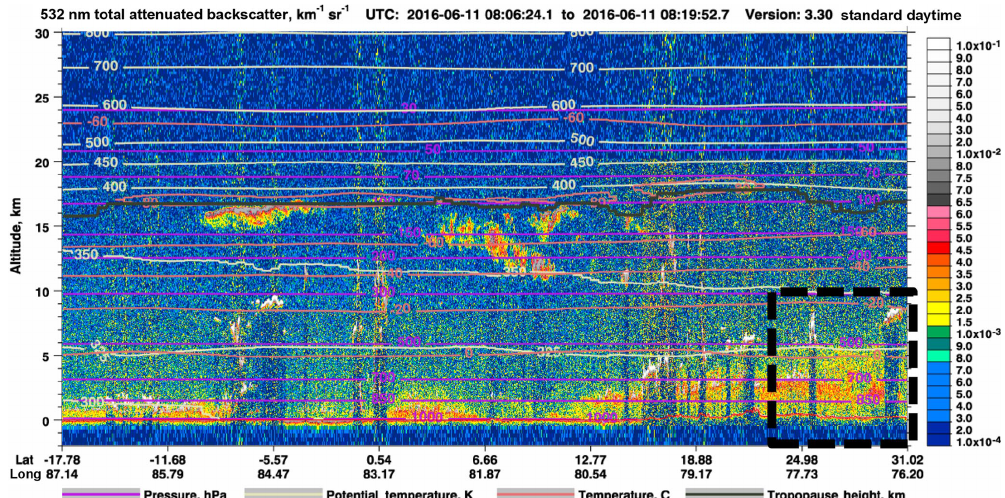
Figure 4. CALIPSO total attenuated backscatter for 11 June (B956) daytime overpass on the Indian subcontinent. Highlighted in the black dashed box is the northern India region of interest, to provide contrast to the on-board lidar retrieval.